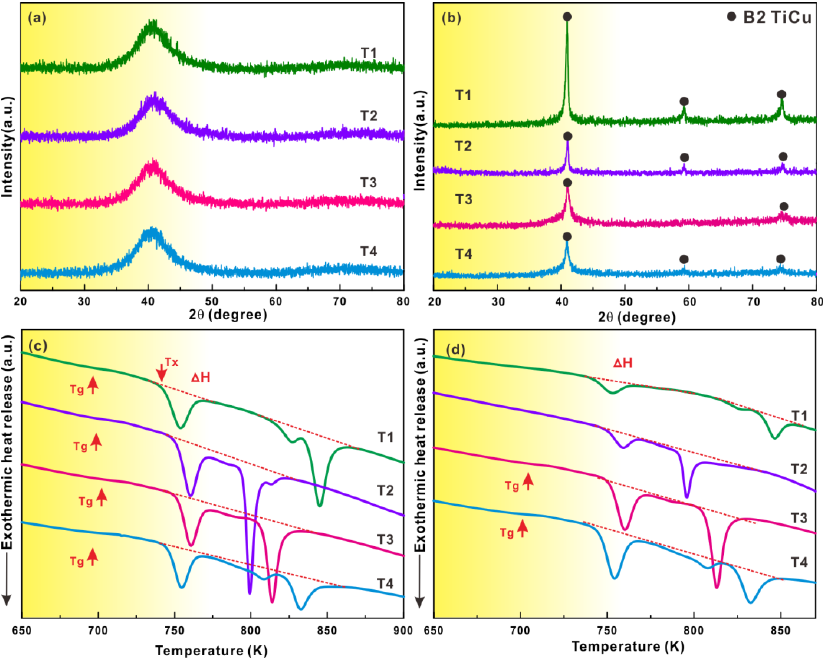
Figure 1. X-ray diffraction (XRD) patterns of the melt-spun T1, T2, T3, and T4 ( a ) ribbons and ( b ) rods with a diameter of 2 mm; differential scanning calorimetry (DSC) curves of the melt-spun T1, T2, T3, and T4 ( c ) ribbons and ( d ) rods.